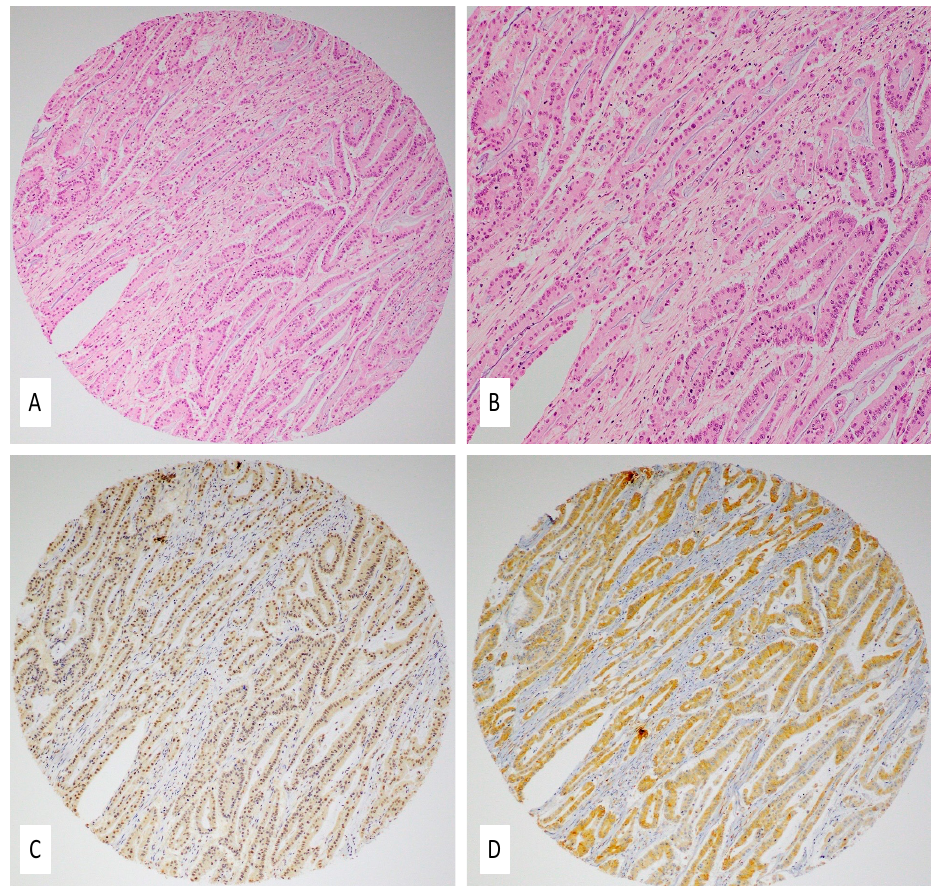
Figure 3. ( A – D ) Coexpression of EBV and HPV in colorectal carcinoma: ( A , B ) hematoxylin and eosin slides (H&E) showing a moderately differentiated colorectal carcinoma (magnifications 10× and 20×, respectively); ( C , D ) IHC revealed diffused and strong LMP1 ( C ) and E6 protein expression ( D ) (10×). Immunohistochemical staining was performed using the standardized avidin–biotin immunoperoxidase method .